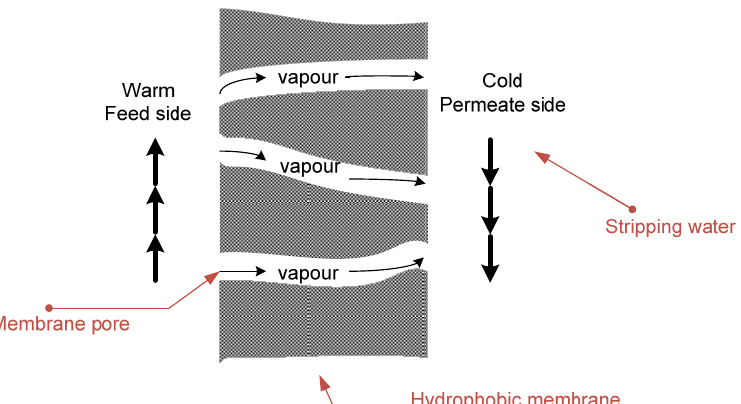
Figure 1. Schematic of DCMD, adapted from